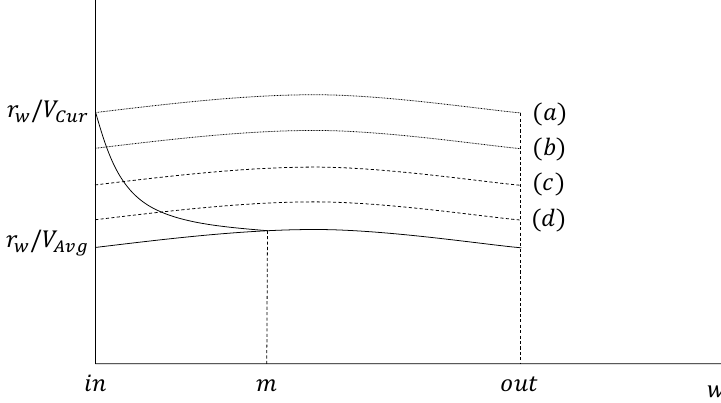
Figure 3. The amount of the precached content when V Avg is faster than V Cur